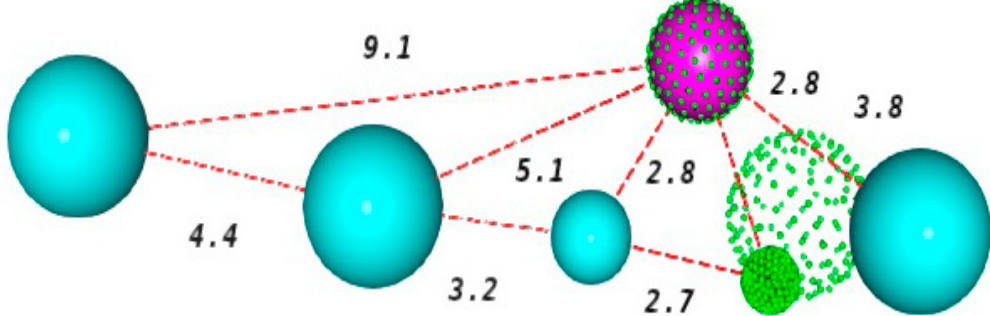
Figure 2. Representation of the best pharmacophore model for KasA inihibitors. Pink: Hbond donor; green: Hbond acceptors; cyan: hydrophobic centers. The size of the spheres represents the tolerance. The distances are shown in angstroms (Å).